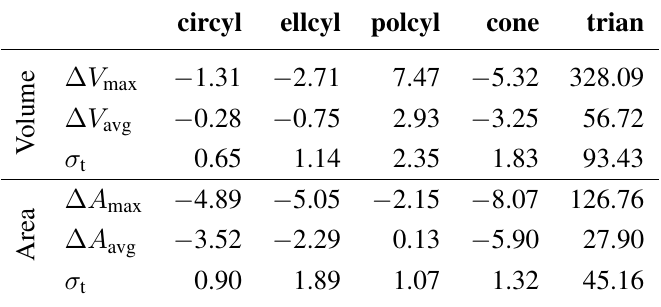
Table 3. Reconstruction results for the generated tree model. Maximum and average difference in percentages for the volume and surface area. Negative values stand for underestimation. The standard deviation ( σ ) in percentage points t